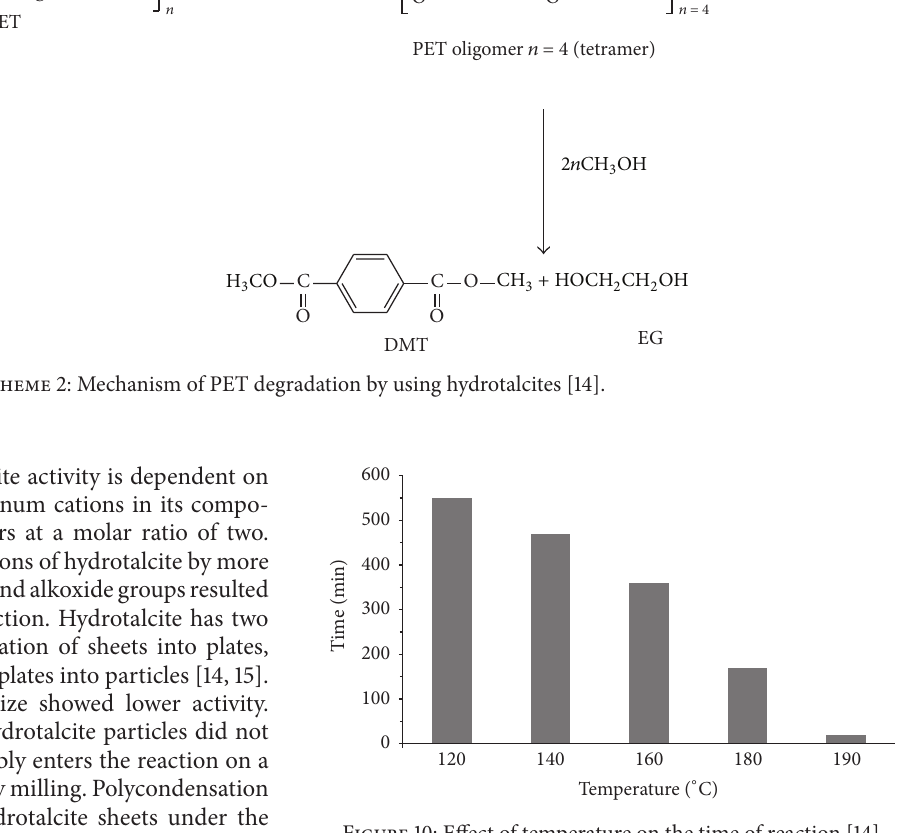
Figure 10: Effect of temperature on the time of reaction [14].